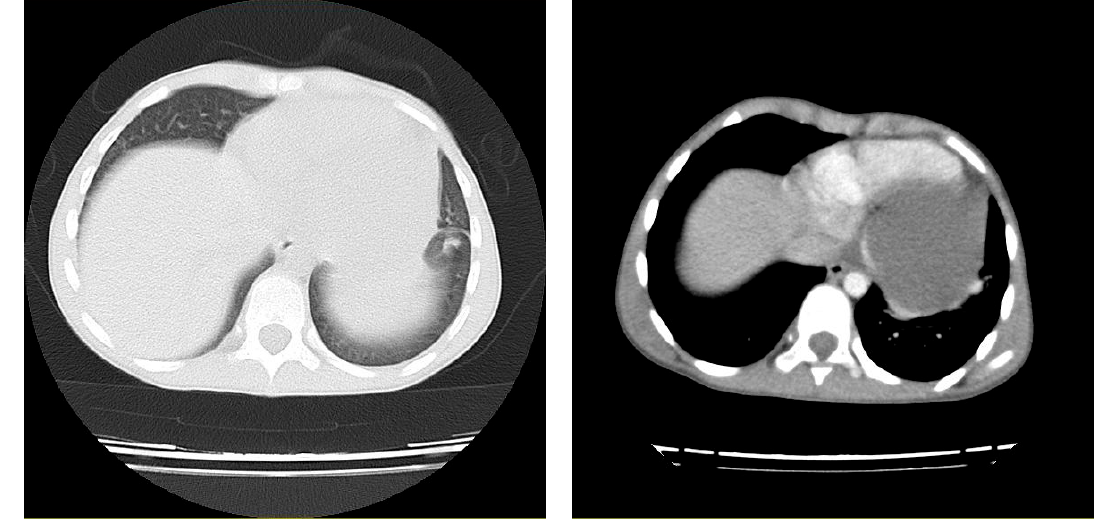
Figure 3. Axial view of the patient’s contrast-enhanced chest computed tomography (CT) scan. A retrosternal mass characterized with a clear serous fluid with compression on the posterior wall of the left ventricle.